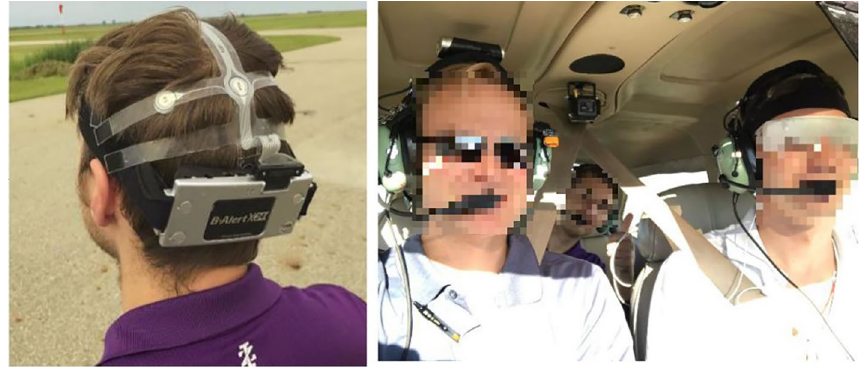
Figure 1. (Left) ABM B-Alert X24 system, (Right) Data collection during live flight (image previously referenced in 9